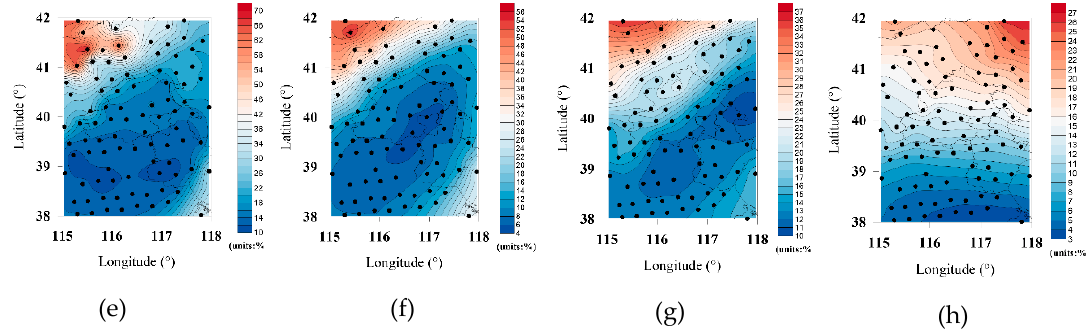
Figure 9. Contour map of the one-dimensional variational retrieval results from 11 December 2018: ( a – d ) retrieved temperature profiles and ( e – h ) retrieved humidity profiles. Each black dot represents 92 samples.